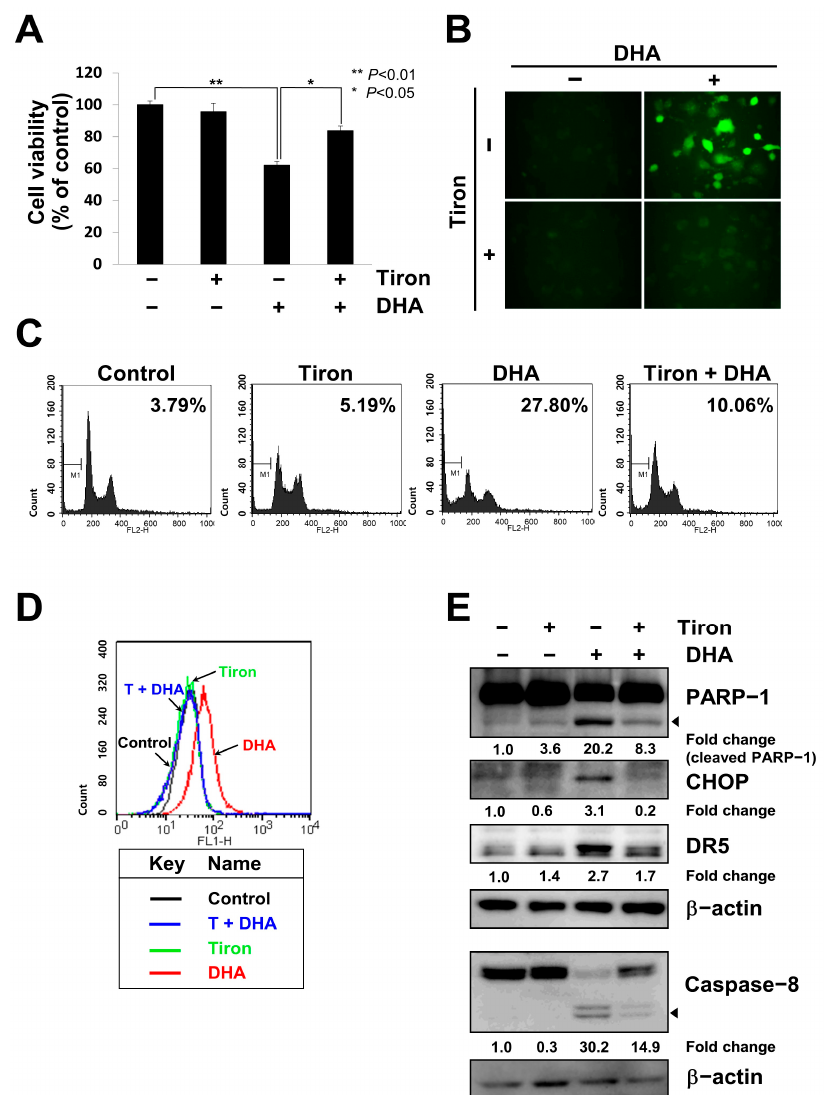
Figure 5. ROS induced apoptosis by increasing the expression of CHOP and DR5 in DHA-treated MH7A cells. ( A ) MH7A cells, pre-treated with or without 4 mM Tiron, an antioxidant, for 1 h were treated with 100 µ M DHA for 24 h, and cell viability was determined using the Ez-cytox assay. ( B ) Cells were treated with 5 µ M DCFH-DA for 30 min before treatment with Tiron, followed by treatment with 100 µ M DHA for 2 h. Production of intracellular ROS was observed by fluorescence microscopy (400 × ). ( C ) Cells treated with 4 mM Tiron for 1 h and 130 µ M DHA for 24 h were stained with PI and subjected to FACS analysis. Apoptosis is expressed as the percentage of cells counted in the sub-G1 phase, as indicated by the bar in the histogram. ( D , E ) MH7A cells pretreated with 5 µ M DCFH-DA for 1 h were pretreated, with or without 4 mM Tiron, for 1 h, followed by treatment with 100 µ M DHA for 2 h. The production of intracellular ROS was observed by FACS analysis ( D ). Cell lysates were subjected to SDS-PAGE, followed by immunoblot analysis using antibodies specific to PARP-1, CHOP, DR5, caspase-8, or β -actin ( E ). Arrows indicate the active form of the proteins. Blots have been cropped down to size for clarity.